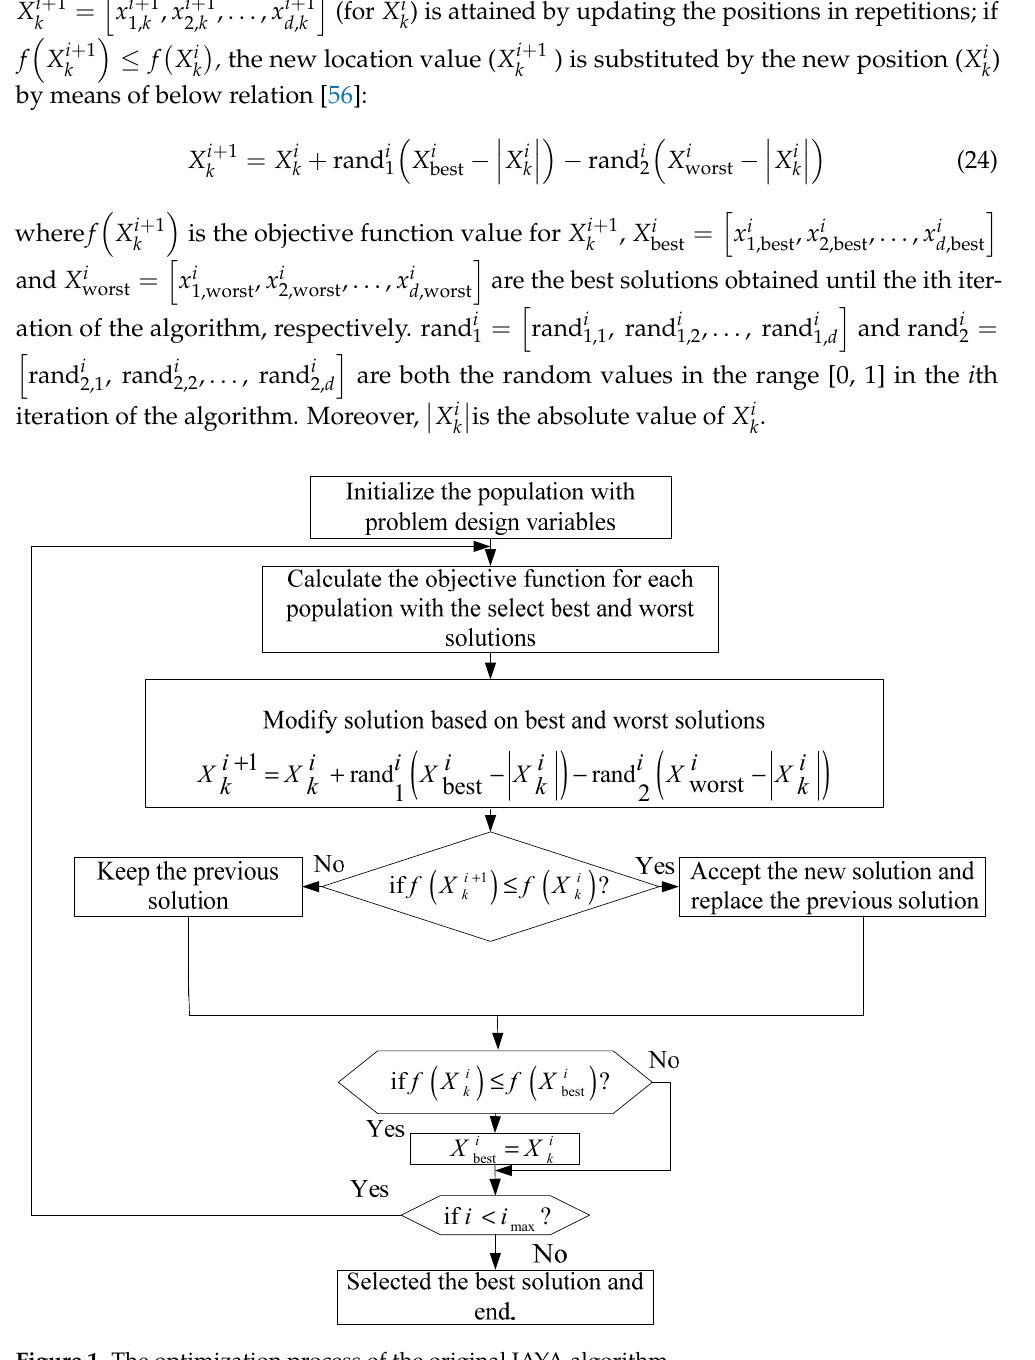
Figure 1. The optimization process of the original JAYA algorithm.